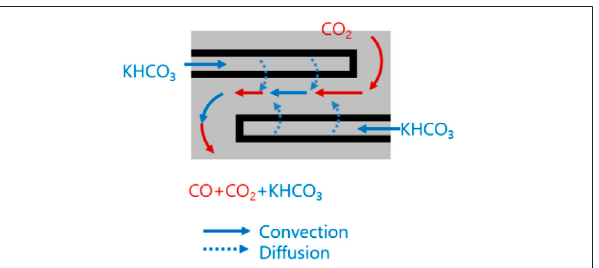
FIGURE 7 | Conceptual fl ow direction of the reactants at the integrated